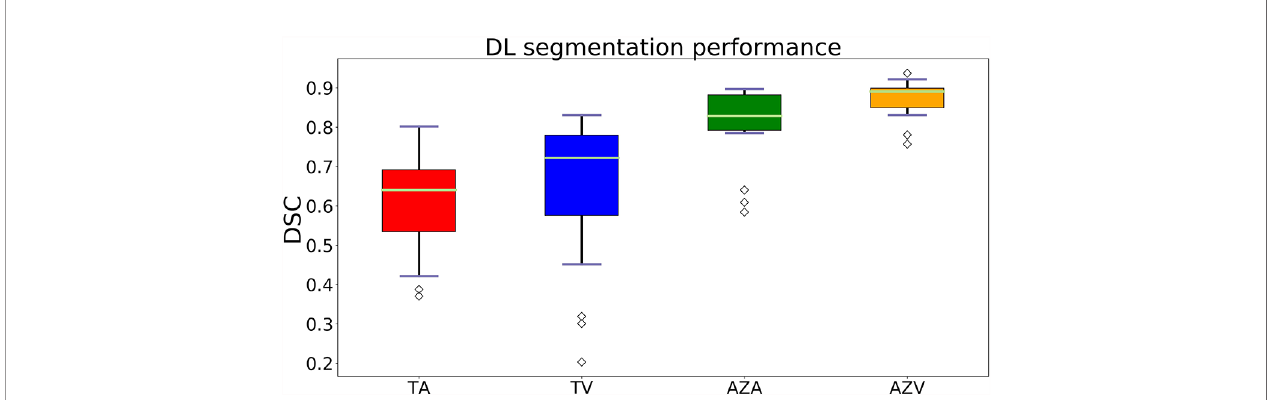
FIGURE 4 | Box-plots of DSC ’ s showing the accuracy of the segmentations. Where TA, tumors on arterial phase; TV, tumors on the portal venous phase; AZA, ablation zones on arterial phase and AZV, ablation zones on portal venous phase.